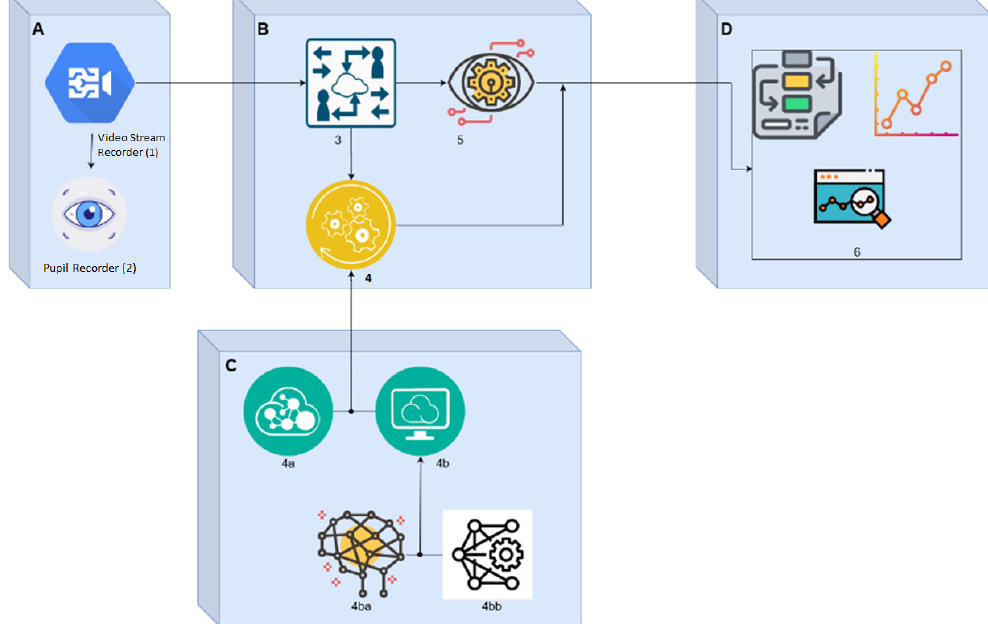
Figure 3. Schematic diagram of a modular workstation structure for recording and analysing operator attention in advanced HMI systems. ( A – D ) denotes consecutive modules for signal processing in the